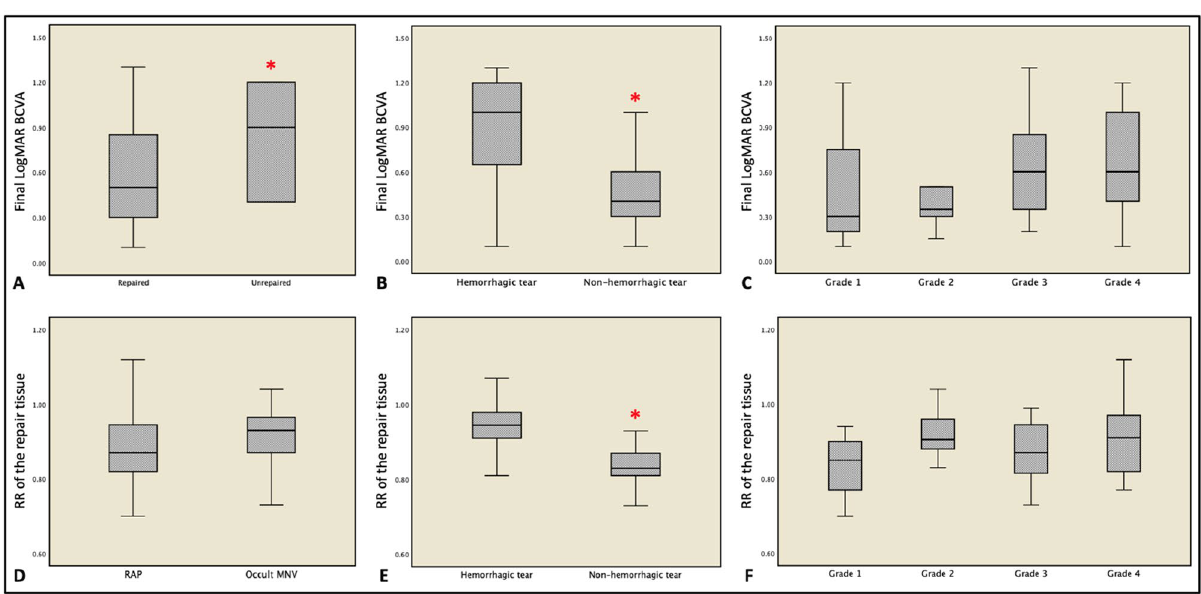
Figure 4. Visual acuity ( A – C ) and reflectivity of the repair tissue ( D – F ) in different patients’ subgroups. Final visual acuity was significantly lower in patients that did not show signs of healing over the follow-up ( A ) and in those cases characterized by a hemorrhagic rip at baseline ( B ). The identification of sub-retinal hemorrhage was also associated with a higher reflectivity of the repair tissue ( E ). Red asterisks indicate statistical significance ( p <